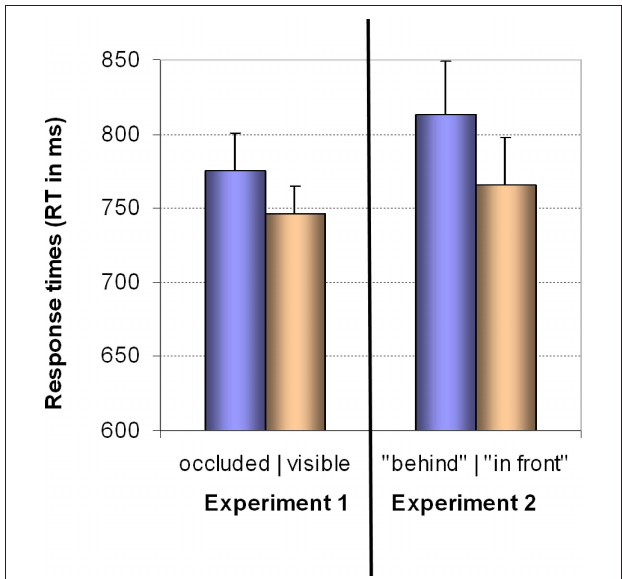
Figure 4 | results for experiment 1 and 2 in the level 1 analysis. Group mean response times (RT) for visible vs. occluded judgments with key presses in Experiment 1 (left graph) and for “in front” vs. “behind” judgments with verbal responses in Experiment 2 (right graph). Vertical bars denote the standard error of mean. Further explanations in the